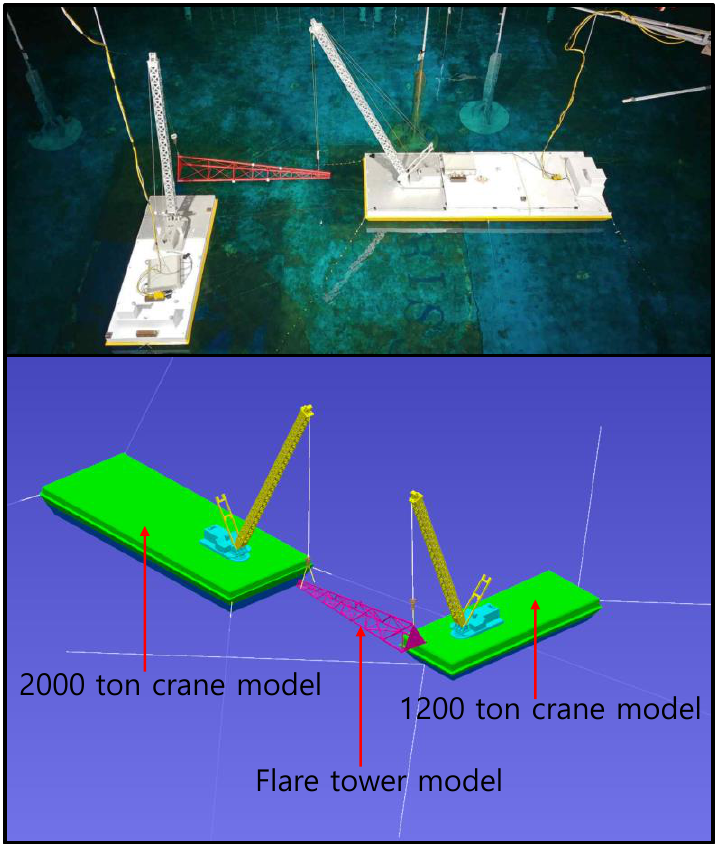
Figure 15. Scene of model test and simulation.